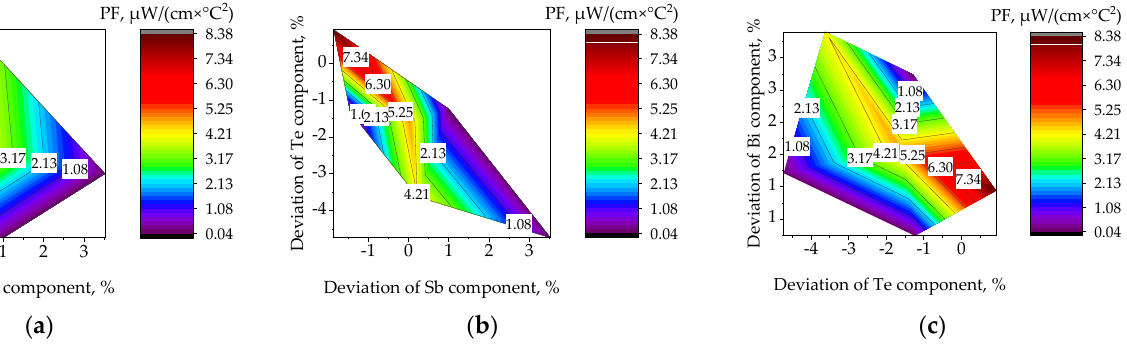
Figure 4. The results of the study of the chemical composition of thin films: plots of thermoelectric power factor, PF, on the deviation of the stoichiometric composition for the main components, Bi, Te, Sb: ( a ) Bi and Sb; ( b ) Te and Sb; ( c ) Bi and